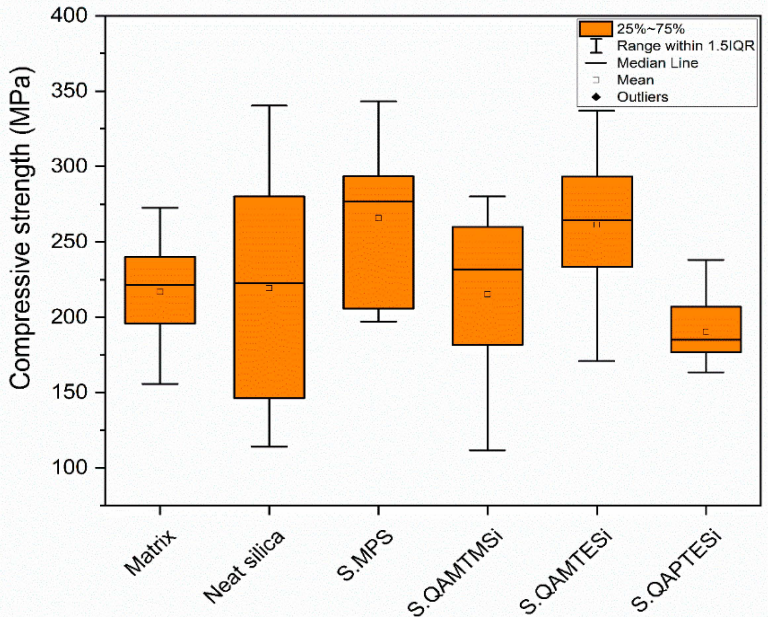
Figure 9. Compressive strength box plots for neat Bis-GMA/TEGMA matrix and experimental resins reinforced with diverse organomodified silica